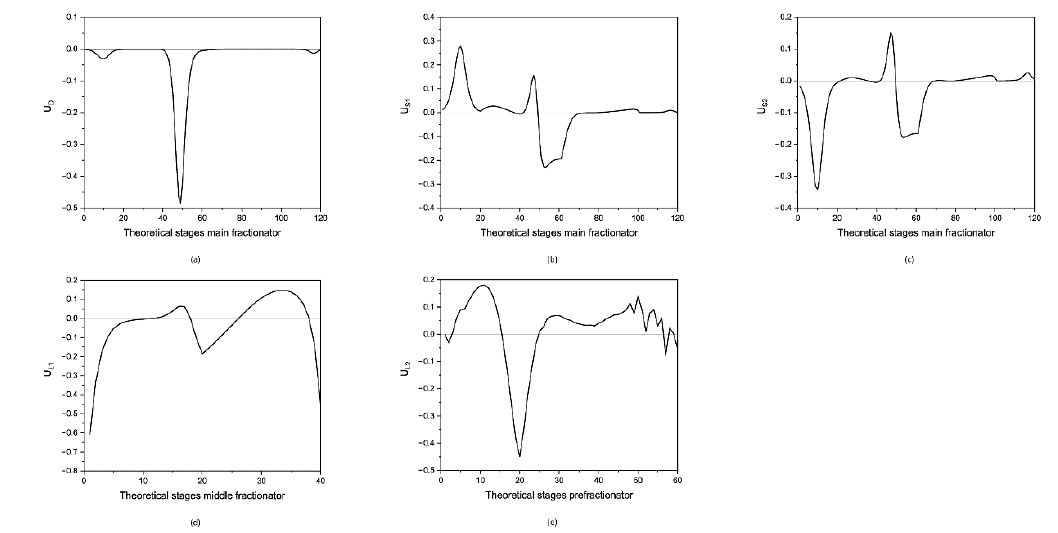
Figure 4. SVD analysis for mixture 1: ( a ) distillate, ( b ) side draw 1, ( c ) side draw 2, ( d ) liquid split 1, and ( e ) liquid split 2.